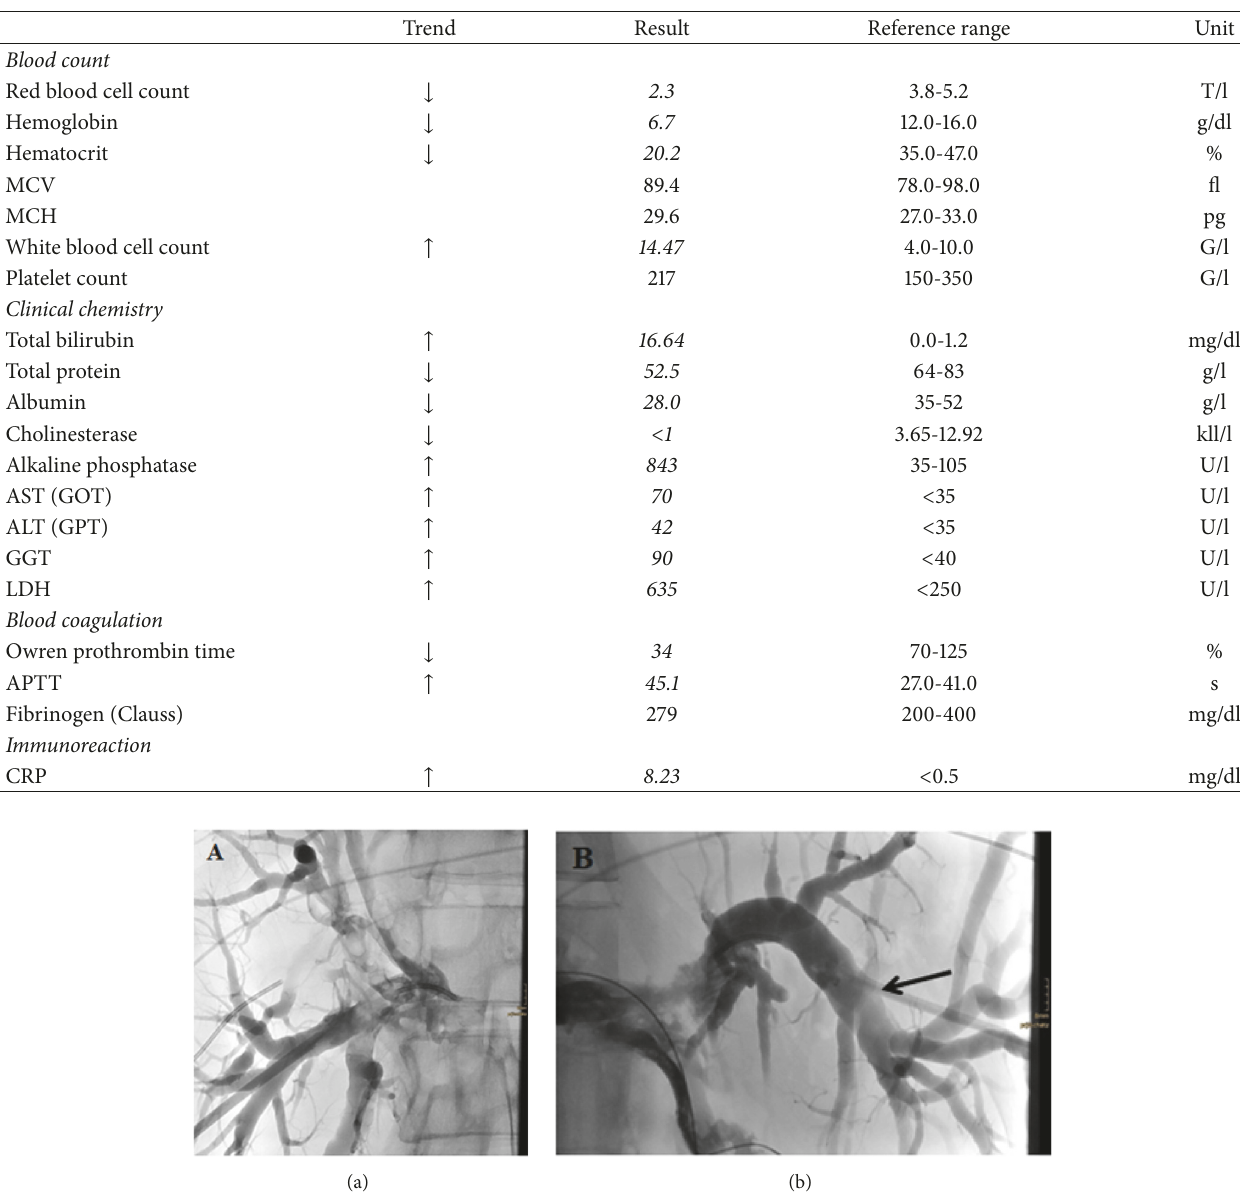
Table1:Laboratoryresultsatthetimeofadmission(MCV=meancorpuscularvolume;MCH=meancorpuscularhemoglobinconcentration; AST = aspartate aminotransferase; GOT = glutamate oxaloacetate transaminase; ALT = alanine aminotransferase; GPT = glutamate pyruvate transaminase; GGT = gamma-glutamyl transferase; LDH = lactate dehydrogenase; CRP = C-reactive protein; APTT = activated partial thromboplastin time).